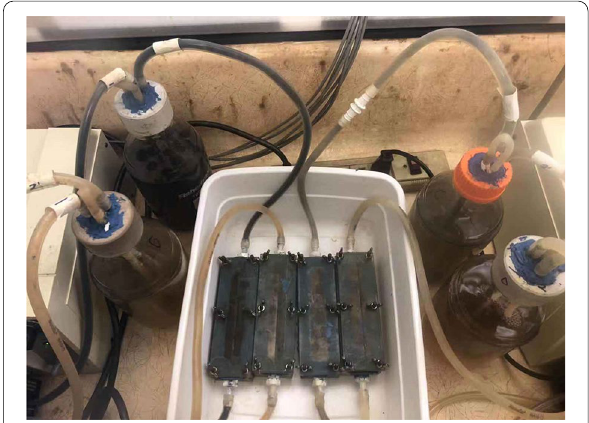
Fig. 2 Biofilm prevention test using different biocide treatments in four independently run flow loop